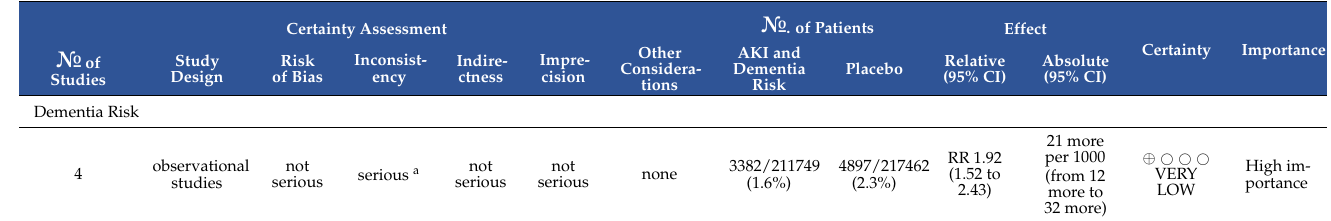
Table 3. Summary of findings table showing certainty of evidence for dementia risk in AKI compared to non-AKI patients. Patients: Dementia risk in AKI patients compared to non-AKI patients. Risk factor : Dementia incidence. Comparisons : Non-AKI patients.